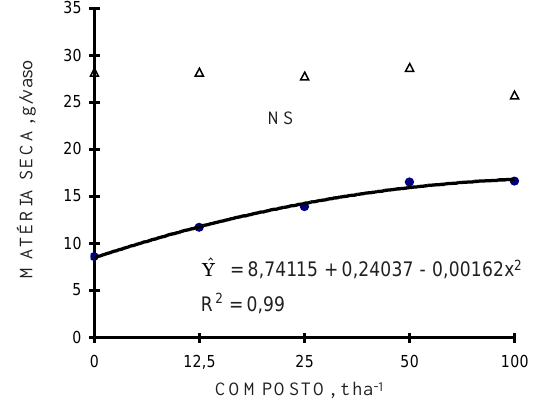
Figura 2. Produção de matéria seca de plantas de sorgo em função de doses do composto de lixo urbano, na presença ( DDDDD ) e na ausência ( ••••• ) de adubação